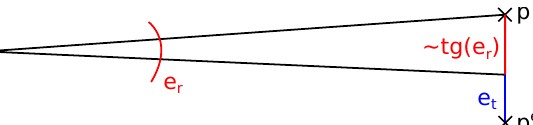
Figure 13. The error of measurement (Euclidean distance between points p and p e ) can be split into rotation e r and translation e t part. The impact of rotation error 2 · tg ( e r /2 ) can be simplified to tg ( e r ) due to near linear properties of tangent function for small